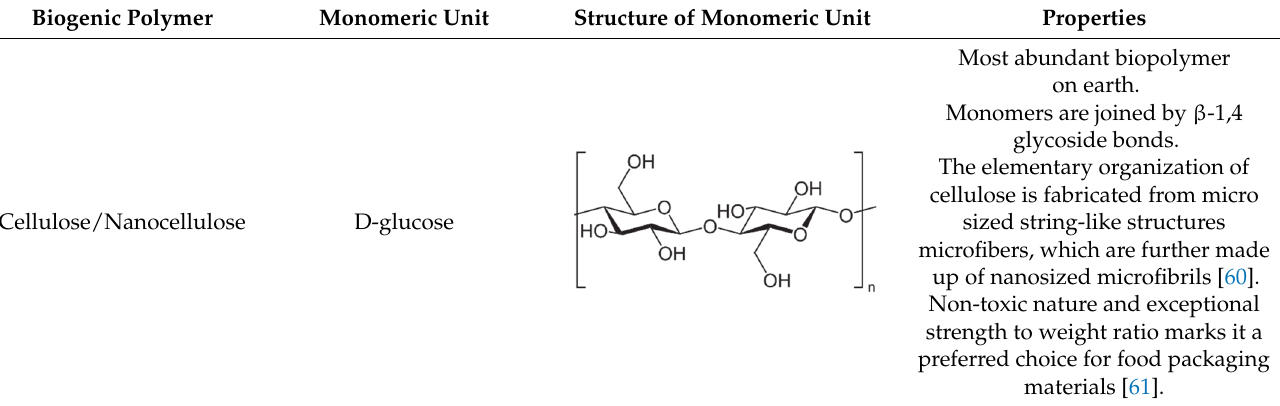
Table 1. Properties of naturally derived biogenic polymers used in food packaging. Biogenic Polymer